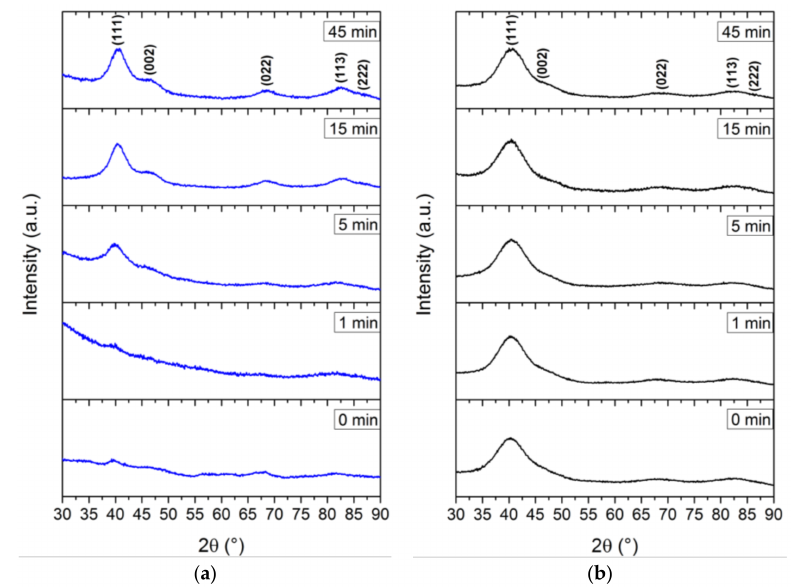
Figure A1. Diffraction patterns of the FePt nanoparticles synthesized in triethylene glycol ( a ) and benzyl ether ( b